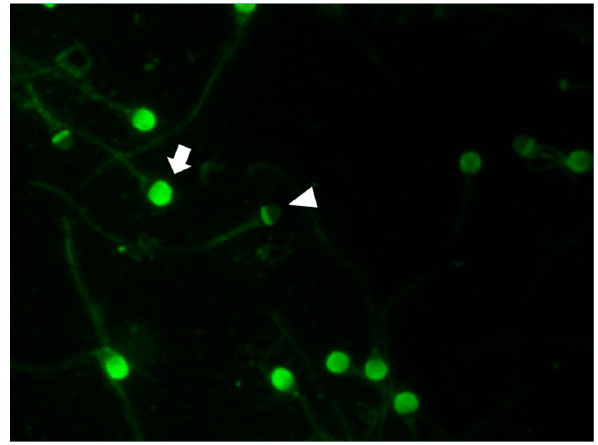
Figure 3. Sperm stained with fluorescein isothiocyanate peanut agglutinin to show sperm with intact (arrow) and damaged (arrowhead) acrosomes.